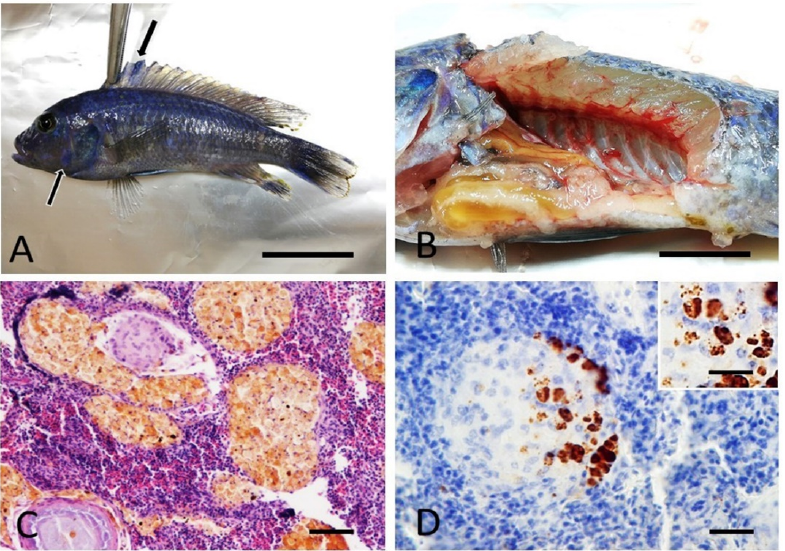
Figure 3. Case 2. Cichlid fish. A. jacobfreibergi . ( A ) Skin. Multifocal, irregularly round black areas (black arrows) of the integument and fins, bar 2 cm. ( B ) Viscera. Scarce perivisceral adipose tissue and intestinal viscera showing a serous content, bar 1 cm. ( C ) Spleen. Multifocal, coalescent granulomas dispersed through the splenic parenchyma. Hematoxylin–Eosin staining, bar 300 μm. ( D ) Spleen, variably-sized round so-called “Hamazaki-Wesenberg” bodies immunolabeled with anti-PAB antibody within macrophages forming the granulomas. Immunohistochemistry, DAB staining, bar 100 μm. Inset shows higher magnification of anti-PAB immunoreactivity. Immunohistochemistry, DAB staining, bar 30 μm.